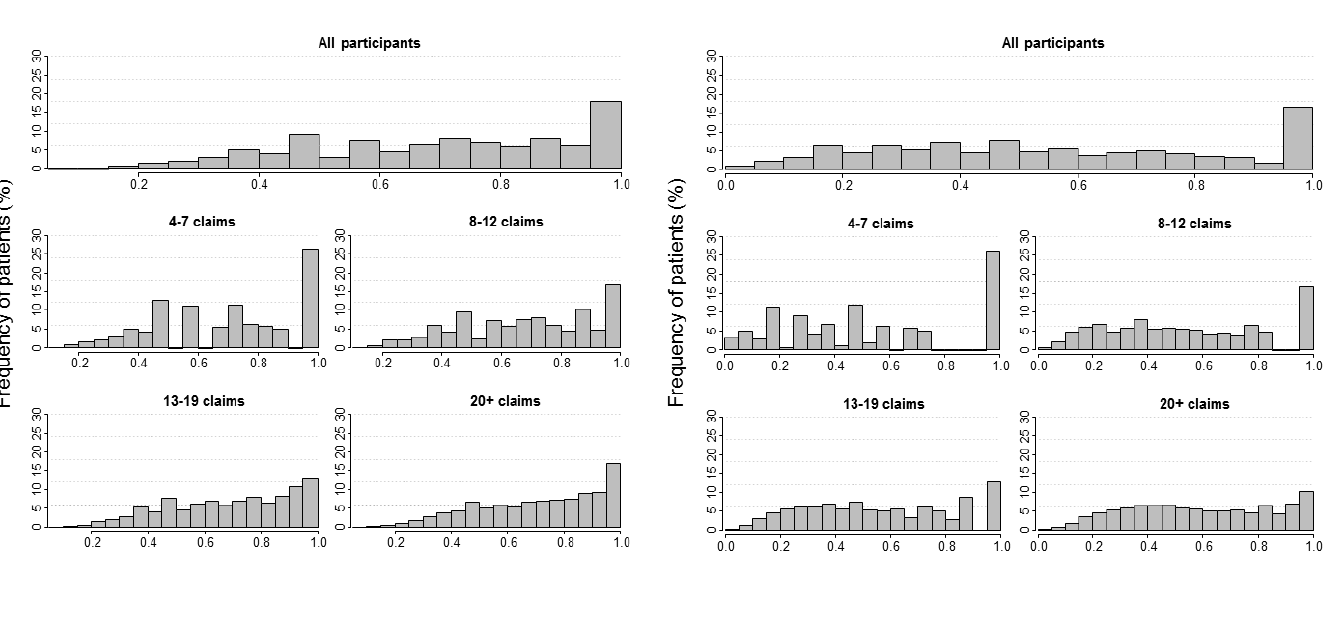
Figure 1: Distribution of continuity of care score among all participants and by quartile of number of GP claims, for (A) usual provider continuity (UPC), and (B) Bice-Boxerman Continuity of Care Index (CoC Index)